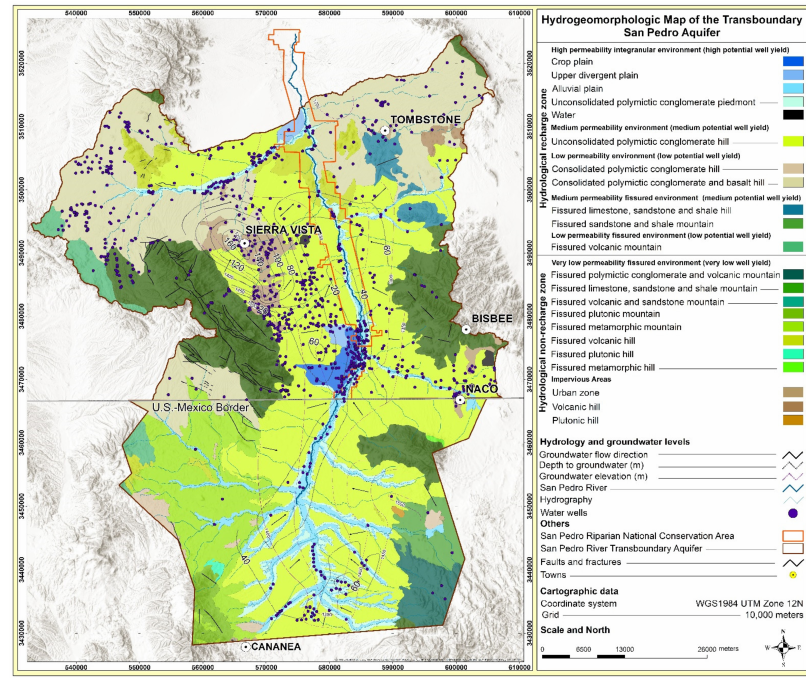
Figure 5. Hydrogeomorphologic map of the San Pedro River